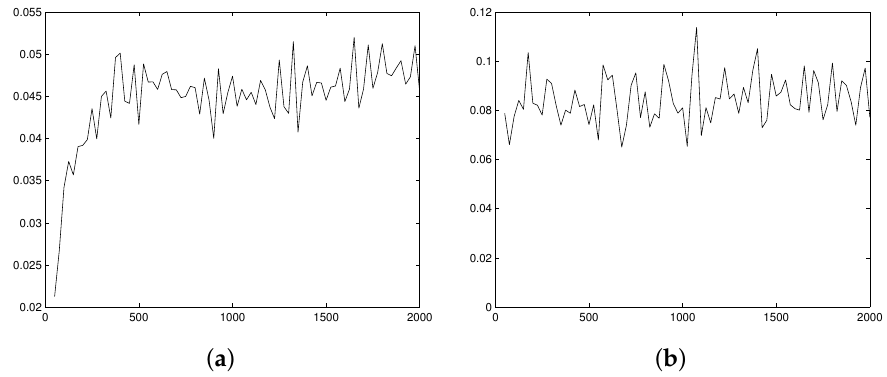
Figure 3. MSE of kernel estimators multiplied by n 3/4 as a function of the sample size n for the triangle density function. ( a ) MSE of estimator with piecewise linear kernel characteristic function. ( b ) MSE of estimator with infinitely differentiable flat-top kernel characteristic function.